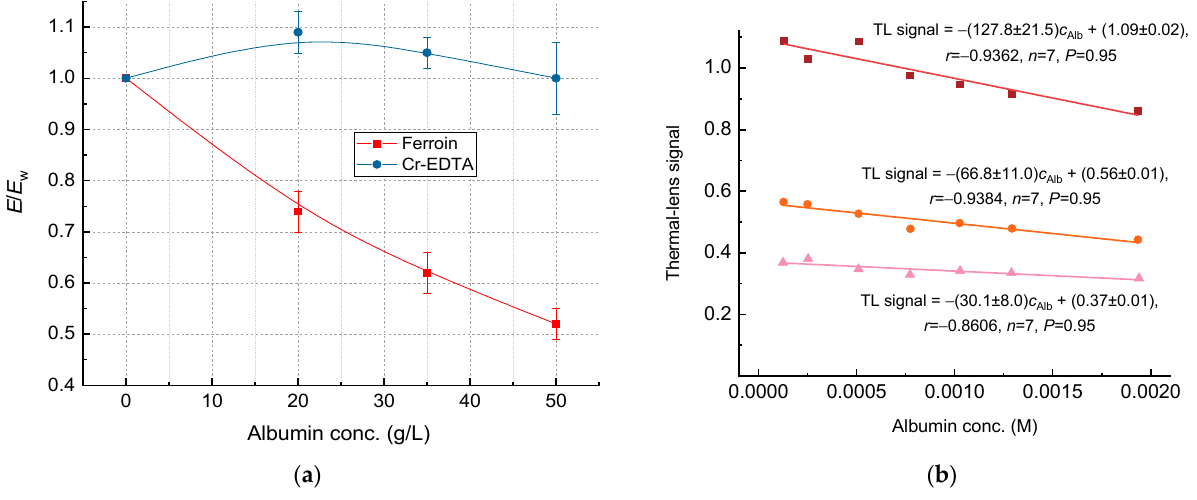
Figure 7. ( a ) Sensitivity coefficient of ferroin and CrEDTA complexes compared to water on the concentration of albumin in the solution, 0.9% NaCl; setup, TLS-60; excitation wavelength, 514 nm; excitation power, 40 mW; ( b ) dependence of the steady-state thermal-lens signal, Equation (7), on the concentration (M) of albumin with different ferroin additions (pink, 5 µM; orange, 8 µM; and dark red, 16 µM). Setup, TLS-300; excitation wavelength, 445 nm; excitation power, 69 mW.